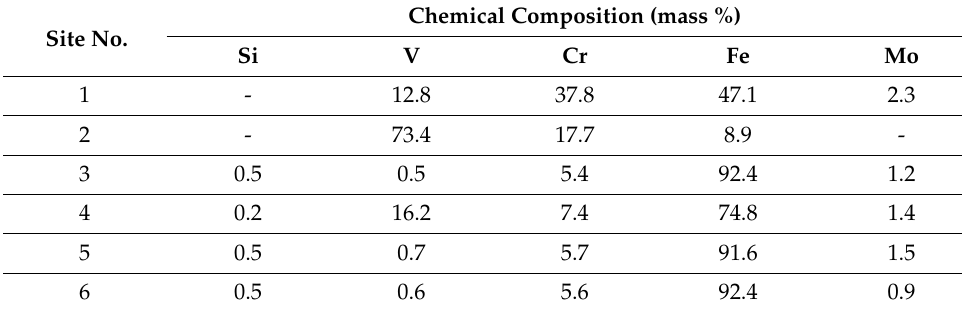
Figure 15. TEM micrograph showing the carbides in martensitic matrix of the specimen after quenching followed by SZT at − 140 ◦ C ( a ), EDS map of Cr ( b ), EDS map of V ( c ). The sites of semi-quantitative EDS measurements are labelled and numbered in the TEM image ( a ). Table 7. Recorded values of EDS measurements from sites in Figure